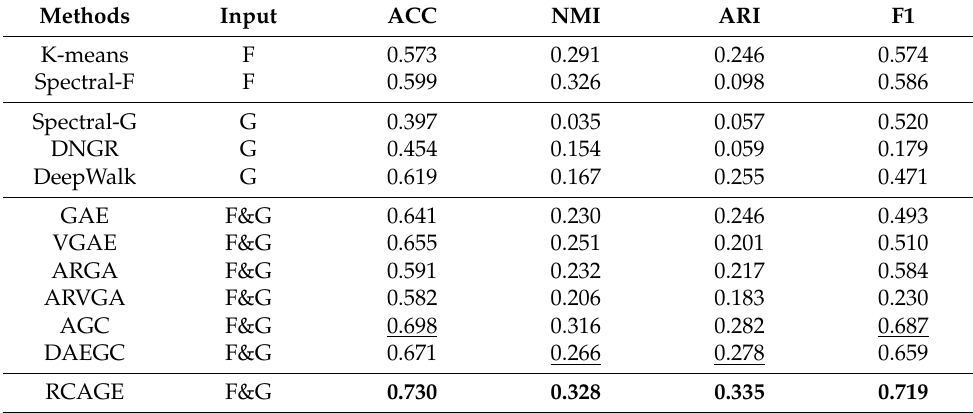
Table 4. Node-clustering performance on Pubmed.